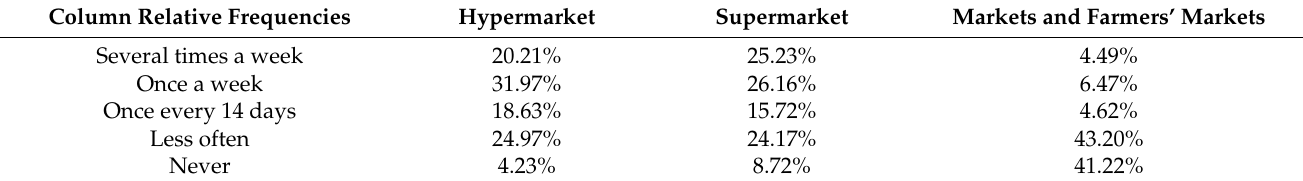
Table 5. Contingency table, place of purchase of organic agriculture and food products and purchase frequency.